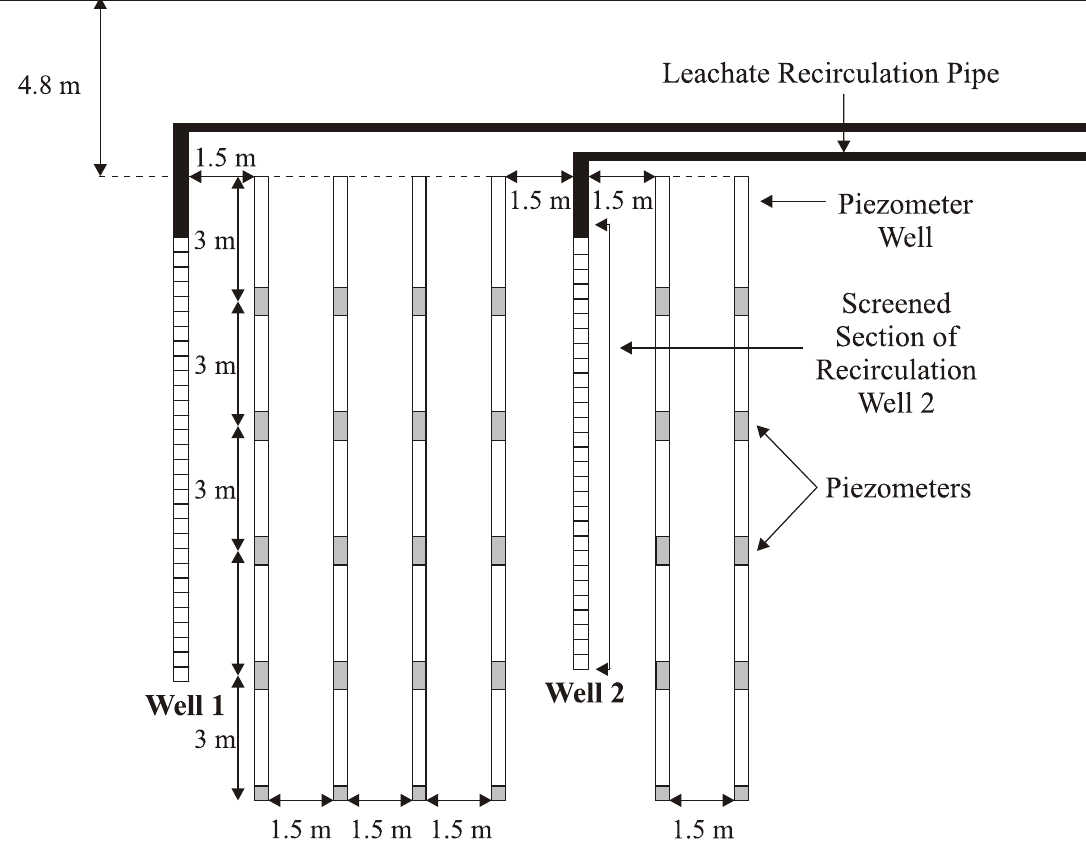
Figure 2. Cross Sectional View of the liquids addition well (Well 2) and the piezometer wells (Cross-section X-X’ in Figure